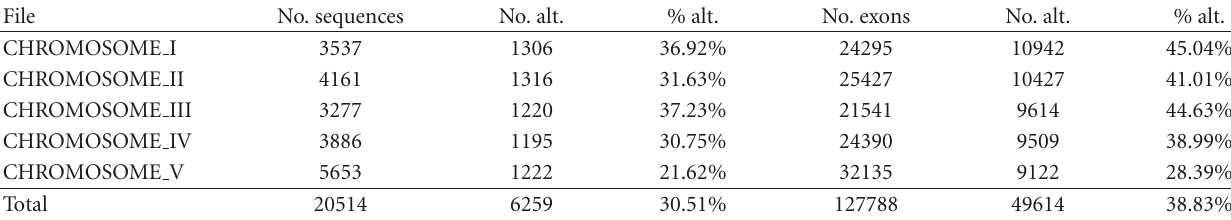
Table 2: Summary of data reduction in C. elegans , chromosomes I–V.